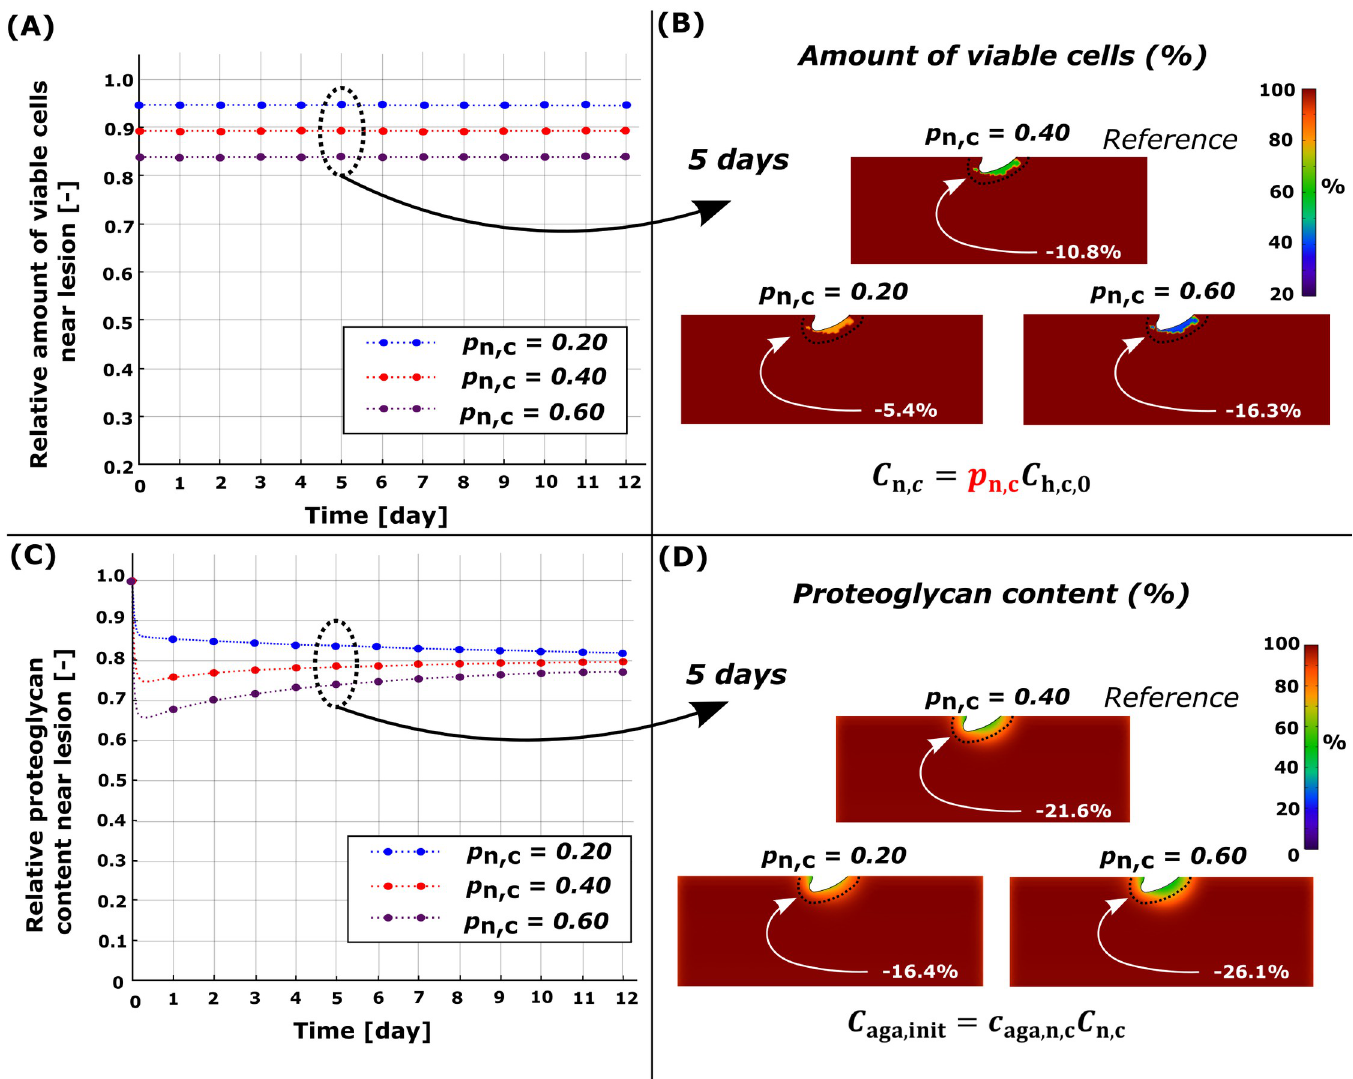
Fig 4. Sensitivity analysis of simulated necrosis rate p n,c . Comparison of temporal and spatial changes at day 5 (A)-(B) in cell viability and (C)-(D) in proteoglycan (PG) content. (C) Higher necrosis rate led to fast PG degeneration at early time points (days 0–1) and partial recovery of the PG content (days 0–3) near the cartilage lesion. Red line in (A) and (C) refers to the reference model ( p n,c =